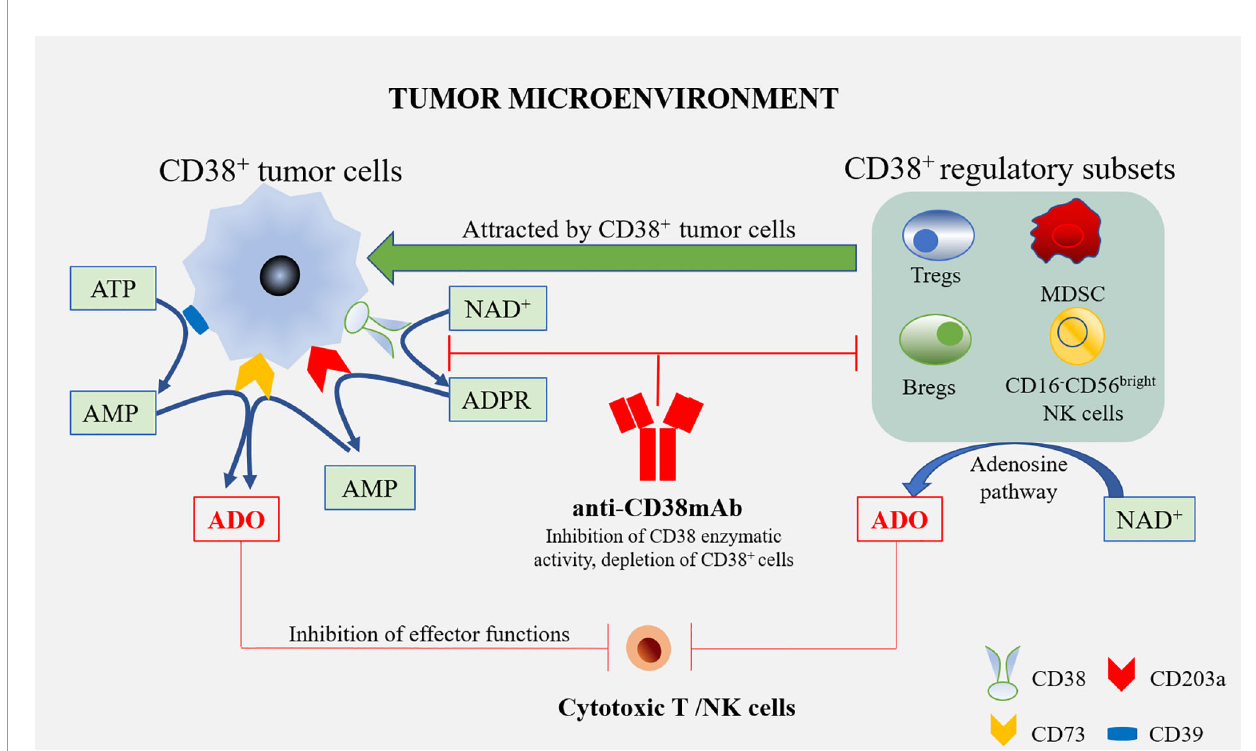
FIGURE 2 | Anti-CD38 mAbs and the treatment of multiple myeloma. Tumor cells are able to attract diverse regulatory subsets, such as Tregs, Bregs, MDSCs, and CD16 - CD56 bright NK cells. All these cells may co-operate in the production of ADO, starting from ATP or NAD + . ADO produced by these cells, as well as tumor cells in the tumor microenvironment, interact with ADO receptors on the cytotoxic T/NK cells to inhibit effector functions, which alleviates the anti-tumor immune response. The treatment of multiple myeloma using Anti-CD38 mAbs might overcome the immune suppression by blocking CD38 ’ s enzymatic activity in these cells, and the depletion of CD38 + cells leads to an increased therapeutic